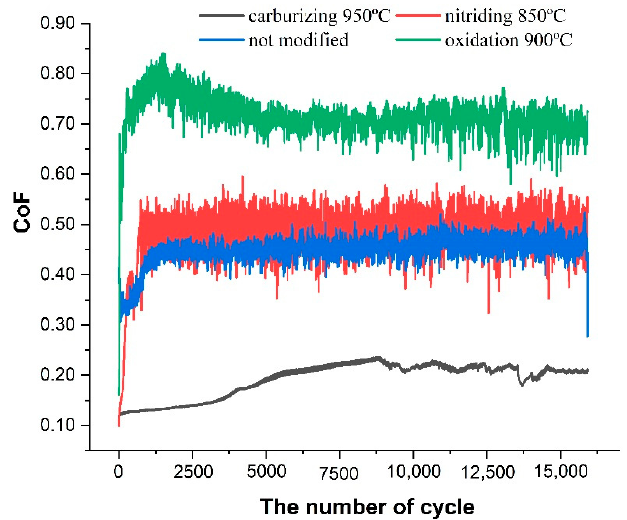
Figure 5. Coefficient of friction of the Ti-6Al-4V titanium alloy before and after thermo-chemical